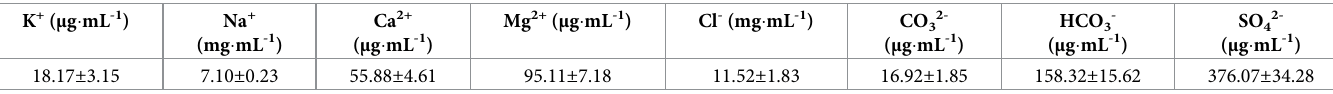
Table 1. Salt ions contents of groundwater under saline